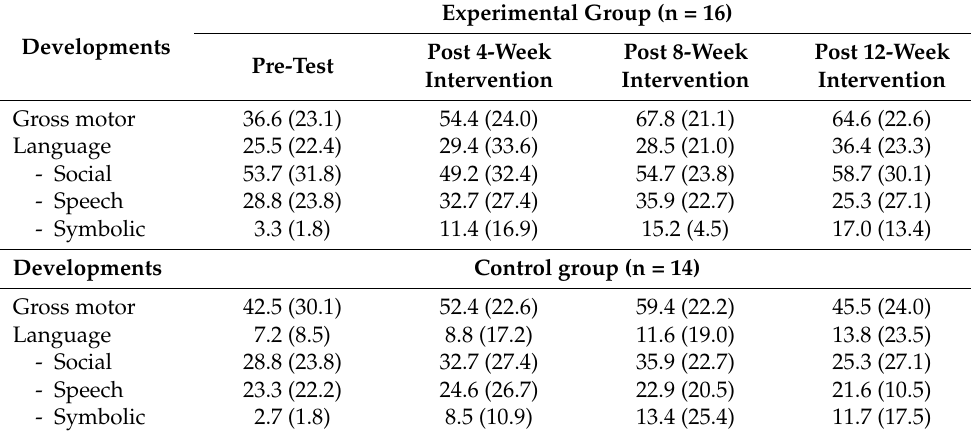
Table 4. Mean (SD) of developmental percentiles at each time point.